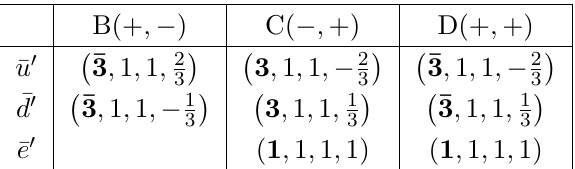
Table 4 . Singlet (cid:12)elds: three possible SU(3) c partners of (cid:22) u The following dimension-5 operators give masses to both left and right-handed neu-